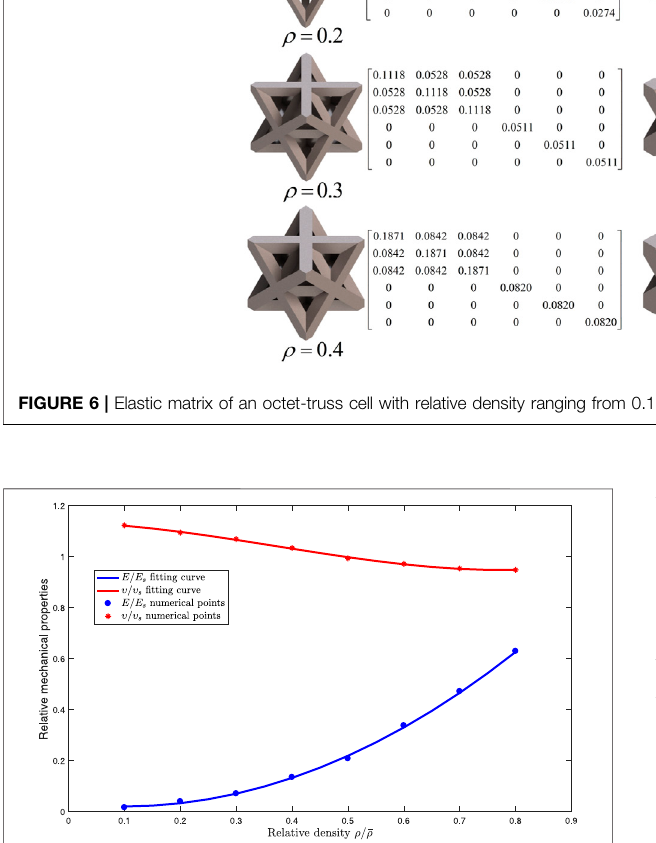
Frontiers in Bioengineering and Biotechnology |